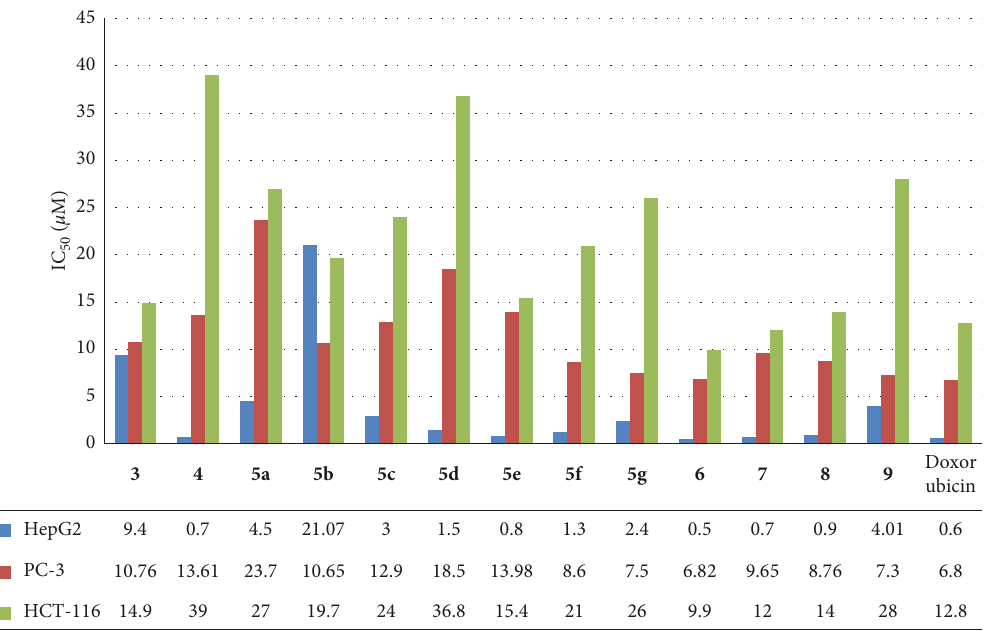
Figure 3: IC 50 of the tested compounds against cancer cell